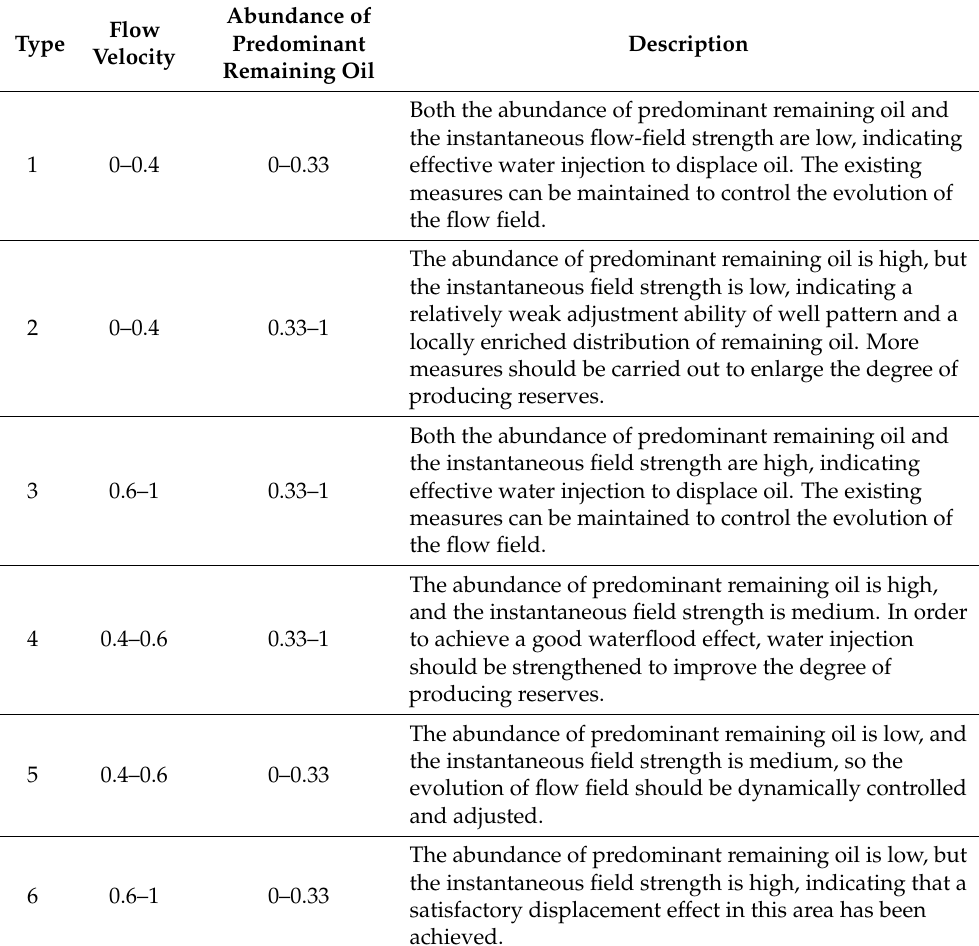
Table 2. Classification of reservoir flow field based on grid attribute